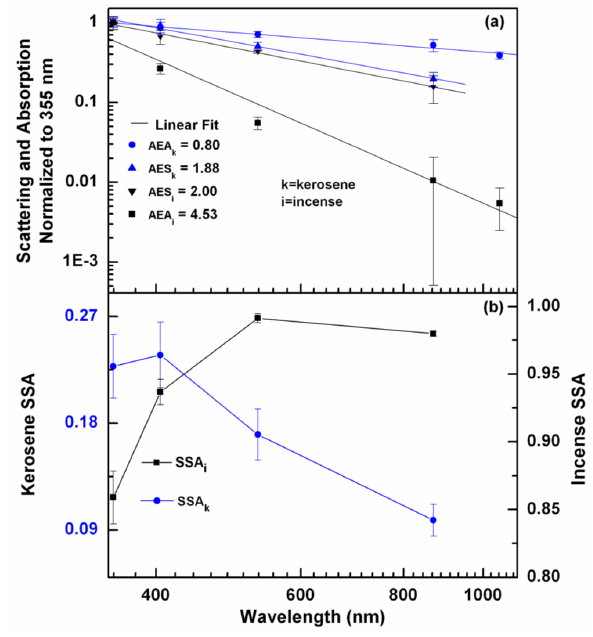
Fig. 2. Intensive aerosol optical properties for kerosene and incense smoke. ˚Angstr¨om exponents of (a) scattering (AES) and absorption (AEA), where error bars indicate the standard deviation of the mean and (b) single scattering albedo (SSA). Uncertainty on SSA was determined by assuming 5% relative uncertainty in photoacoustic absorption coefficient measurements and 15% relative uncertainty in scattering coefficient